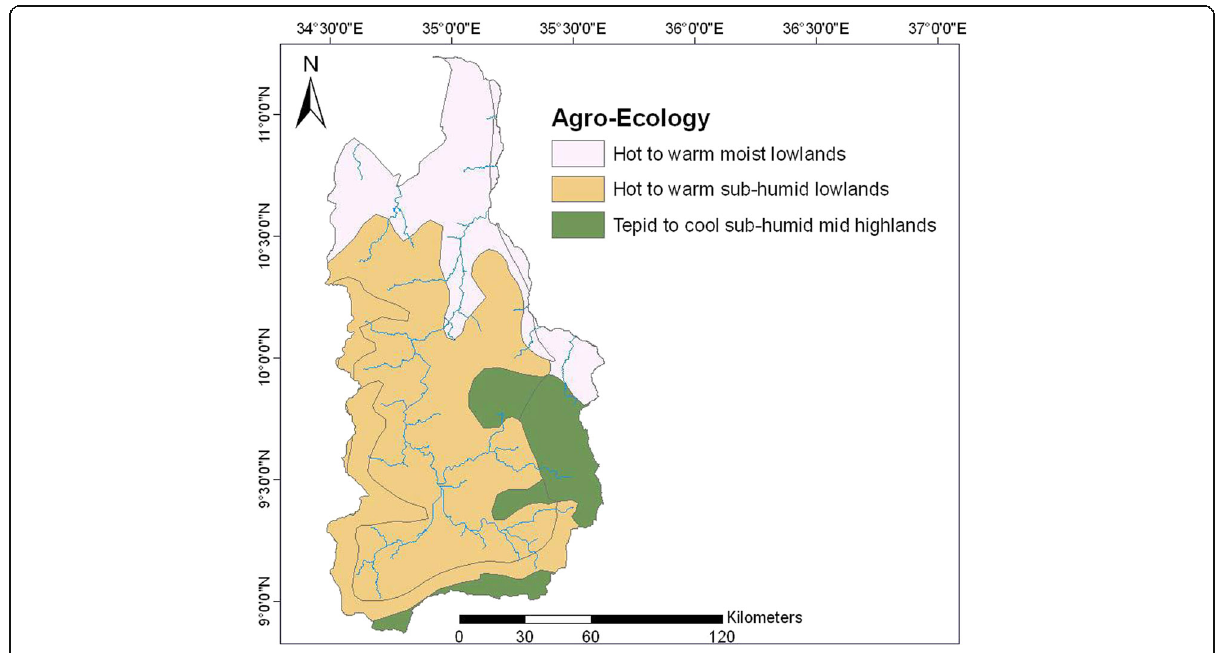
Fig. 1 Location map of the research